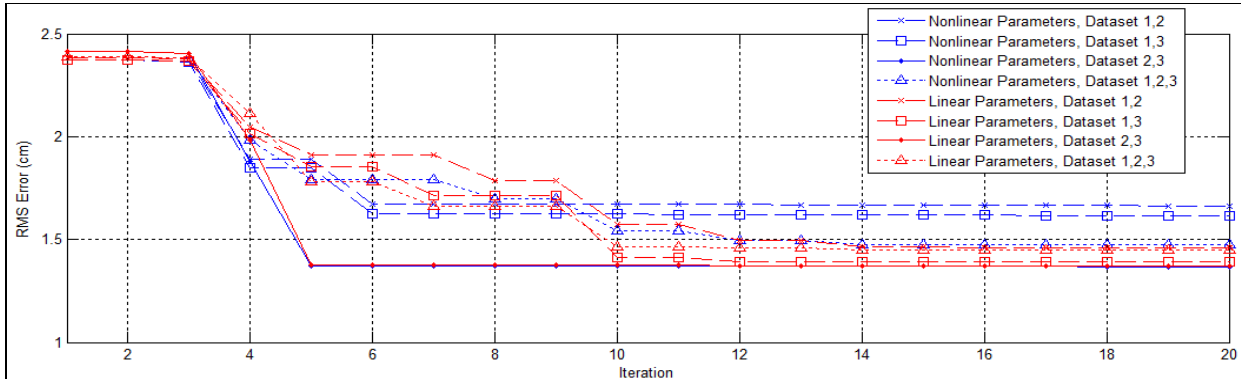
Figure 11. Convergence of different parameter representations.